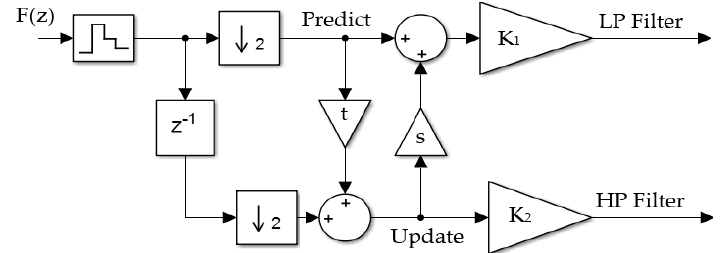
Figure 3. Schematic of lifting wavelet transform.